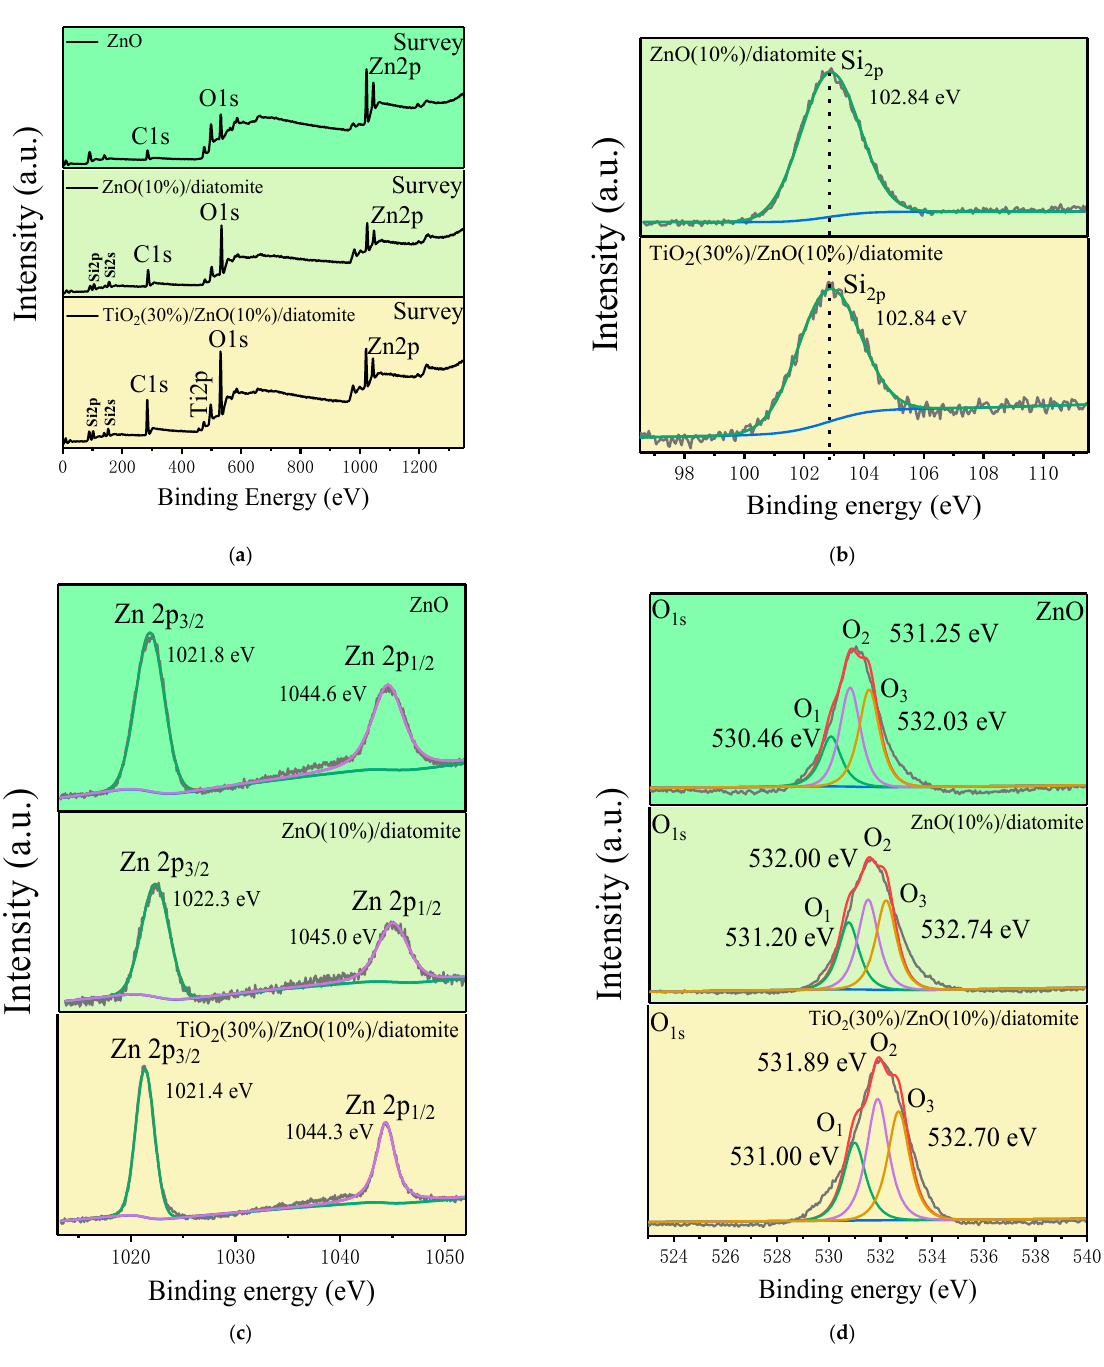
Figure 4. XPS ( a ) survey, ( b ) Si 2p, ( c ) Zn 2p, and ( d ) O 1s spectra for ZnO, ZnO(10%)/diatomite, and TiO 2 (30%)/ZnO(10%)/diatomite. Table 1. Proportion of the three oxygen species of ZnO, ZnO(10%)/diatomite, and TiO 2 (30%)/